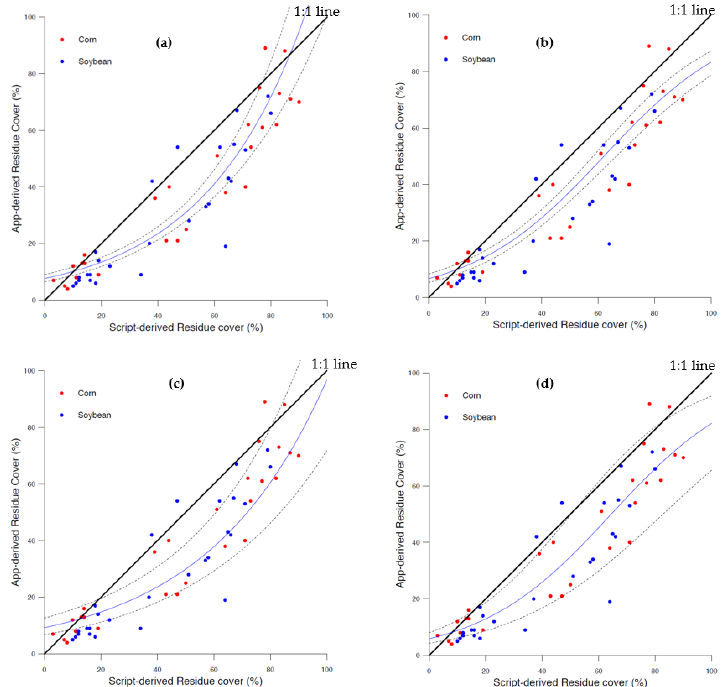
Figure 5. Relationships between residue cover percent as determined by photograph-grid and app with 95% CI: ( a ) OLS log-linear regression; ( b ) OLS logit-linear regression, ( c ) generalized Poisson regression; ( d ) Beta regression with logit link.